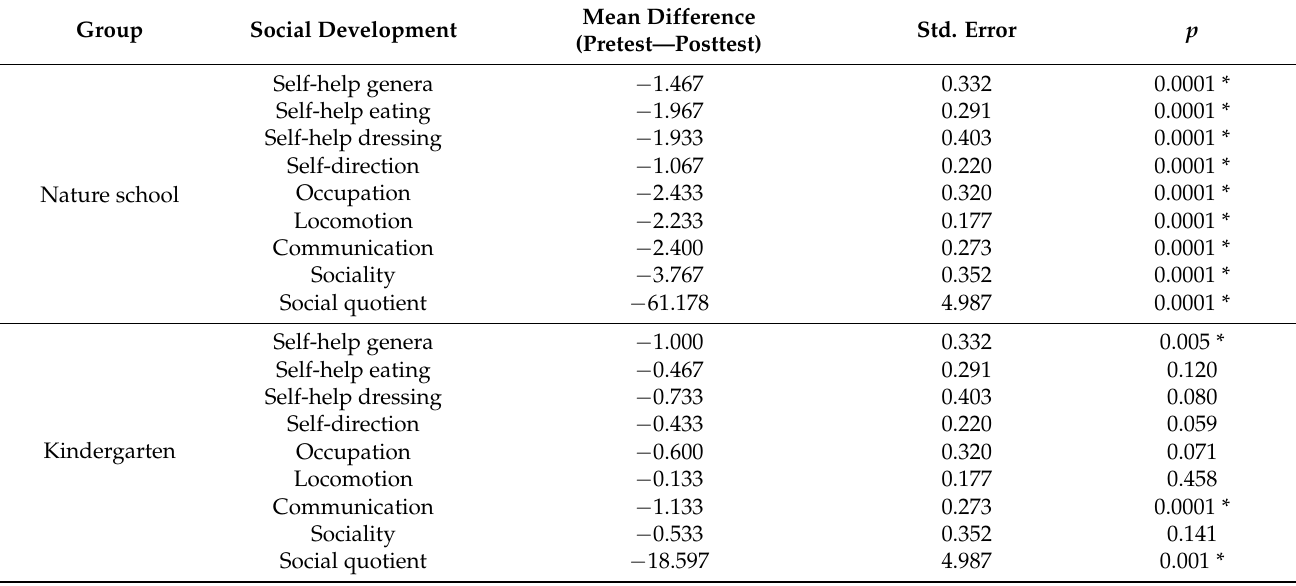
Table 4. Differences of the social development within groups pre- to